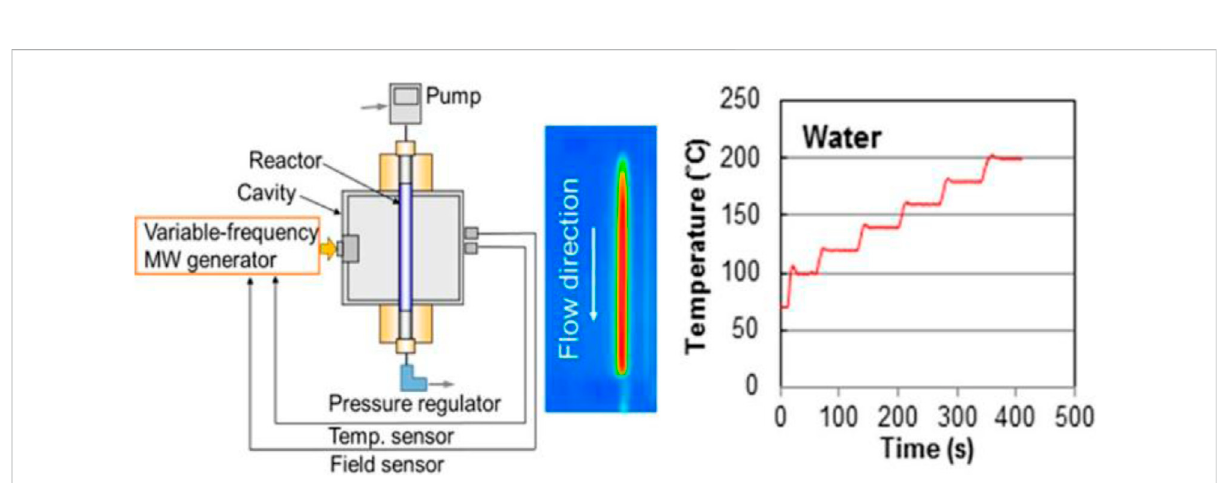
FIGURE 7 Experimental setup of the MW-assisted fl ow reactor system and image of the MW cavity. The quartz reactor tube relates to the PEEK sheath, which is designed to resist up to 10 MPa. Reprinted with permission from (Nishioka et al., 2013). Copyright (2013) American Chemical